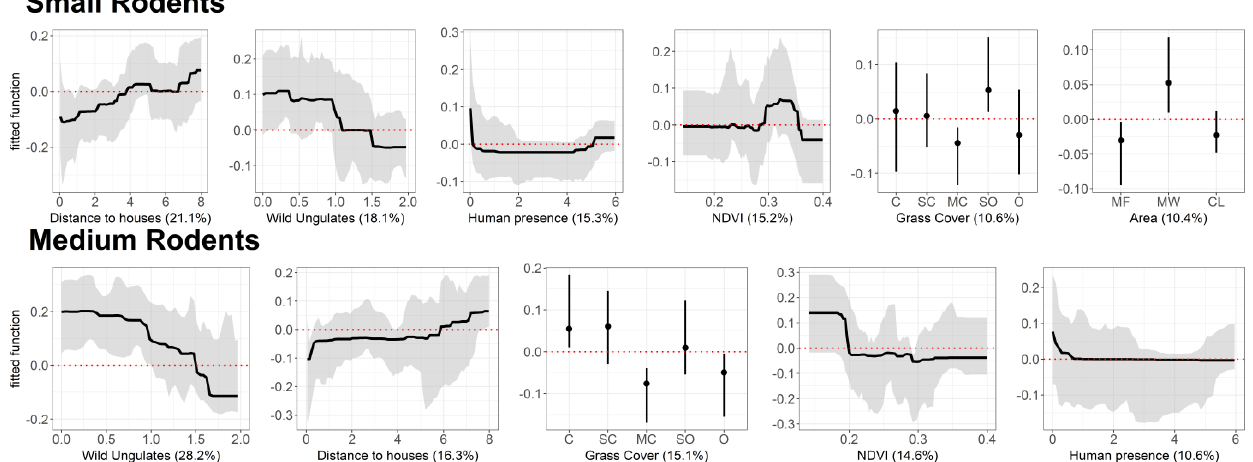
Figure 4. Variation in abundance (fitted function) predicted from the boosted-regression-tree (BRT) models, for the most important predictors of rodent abundance (relative importance > 10%). The 95% confidence intervals of each variable are represented in grey and the red dotted line represents the boundary between the positive and negative effects. Functions are continuous for all variables, except for grass cover and area – grass cover: C − continuous, SC − sub-continuous, MC − moderately closed, SO − semi-open, O − open; area: MF − Mixed farms, MW − Mun-ya-wana, CL − Communal lands. A common scale is used on the vertical axis for all plots (see Table 1 for variable units).